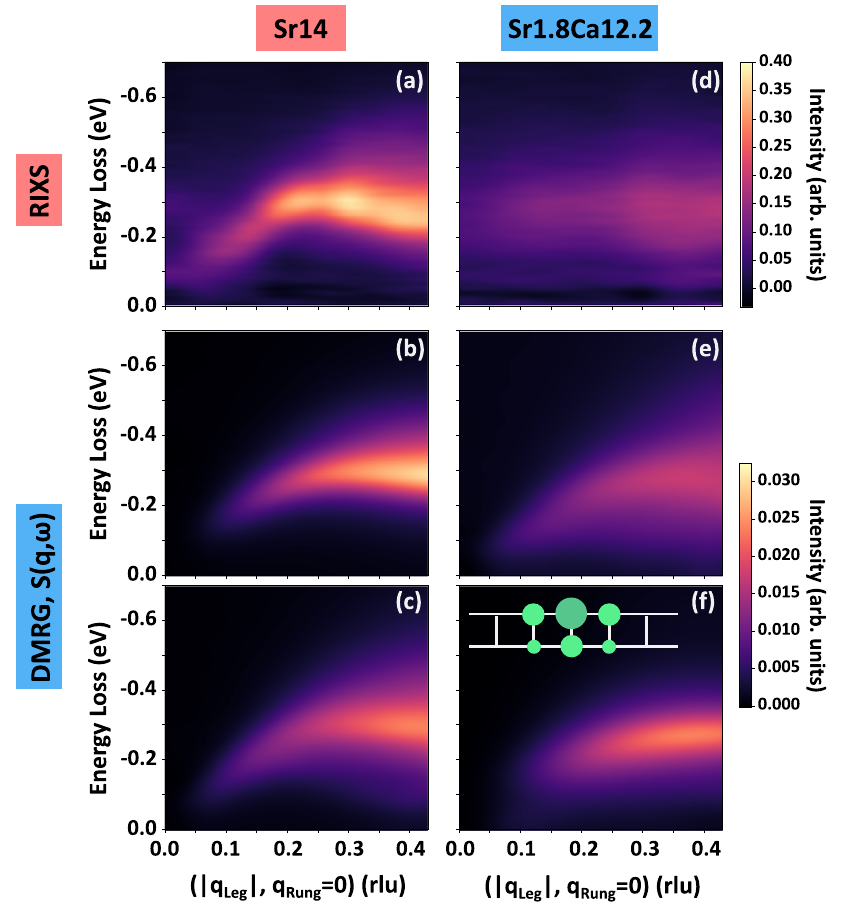
Fig. 2 Experimental and theoretical RIXS spectra with Ca-doping effects. a – c ( d – f ) Cu L 3 -edge RIXS results for Sr14 (Sr1.8Ca12.2). The elastic line in each of the experimental spectra is subtracted for clarity. a , d Momentum-dependent RIXS experimental spectra for Sr14 and Sr1.8Ca12.2 in σ polarization with bicubic interpolation. b Calculated Δ S = 1 RIXS spectra on an undoped ladder cluster for Sr14. c , e Calculated Δ S = 1 RIXS spectra on doped ladder clusters with hole doping p close to the experimentally determined values from O K -edge XAS results, which are about 6% and 11% for Sr14 and Sr1.8Ca12.2, respectively. The following set of parameters are applied for Sr14 (Sr1.8Ca12.2) on a 32 × 2 site cluster with spectral convergence: t leg ¼ 340 meV, U ¼ 8 t leg , and r ¼ 0 : 85 ( t leg ¼ 300 meV, U ¼ 9 t leg and r ¼ 1 : 1457 ). f Calculated Δ S = 1 RIXS spectra for Sr1.8Ca12 on a 16 × 2 site doped ladder cluster with an impurity potential V imp ¼ 0 : 5 U . We make additional assumptions that the on-site impurities (green circles) are screened poorly, and their potential extends to neighboring